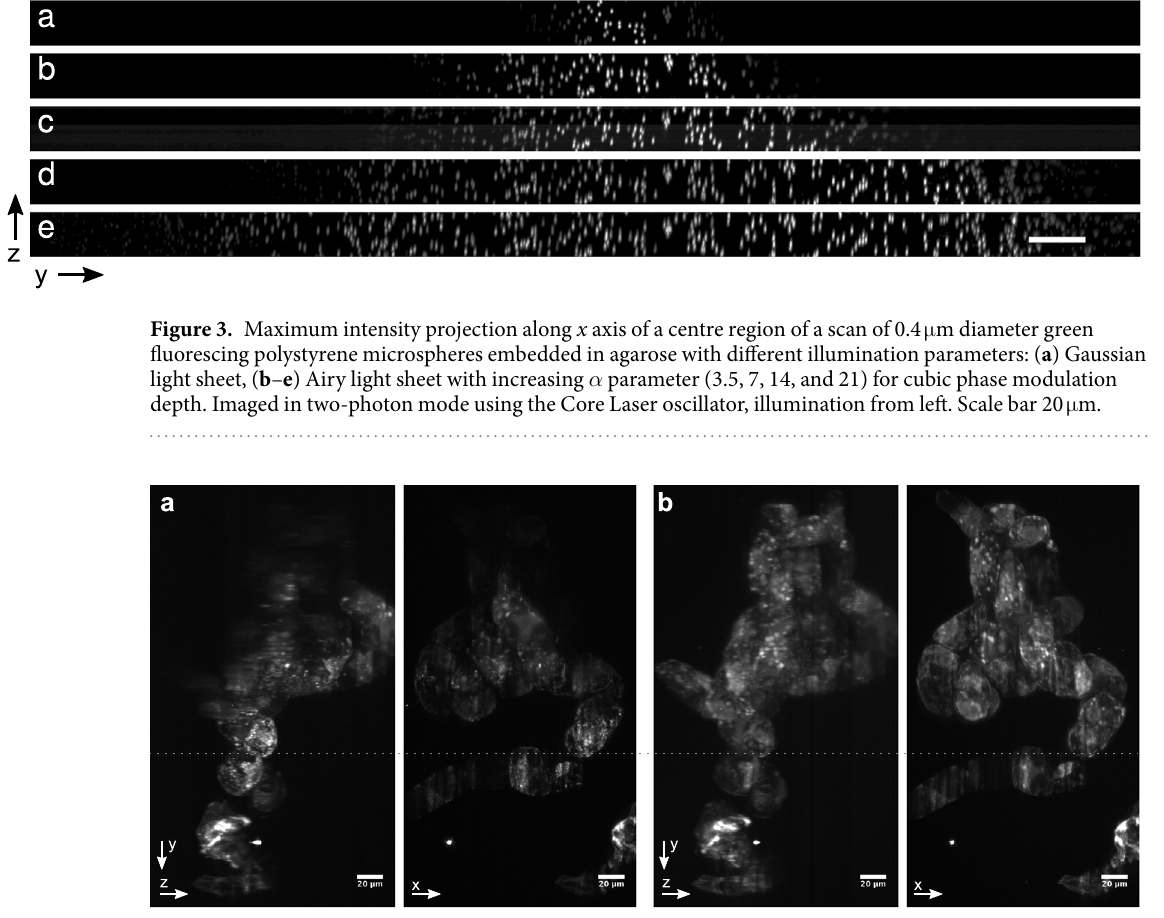
Figure 4. Maximum intensity projections along x and z axes of an agarose embedded cluster of BY-2 cells expressing actin-RFP. ( a ) Gaussian light sheet, ( b ) Airy light sheet ( α = 7). Imaged in two photon mode using the HighQ-2 laser, scale bar 20 μ m. The dashed orange line shows the approximate position fo the focal plane of the excitation